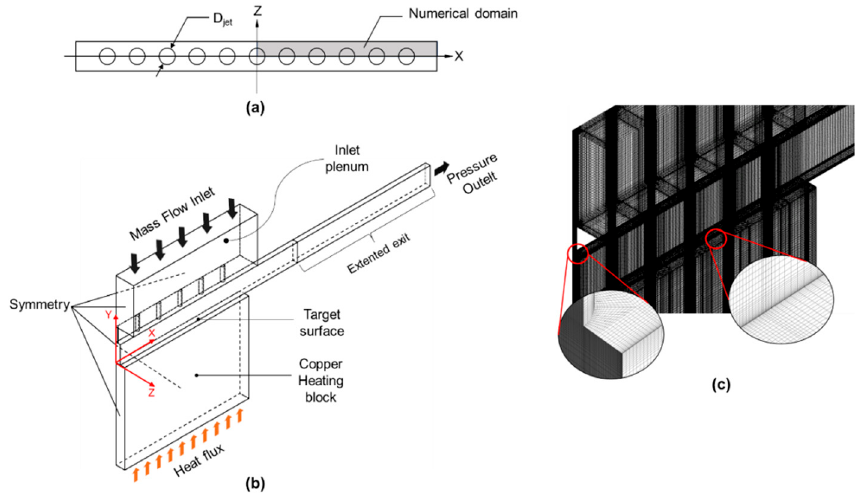
Figure 4. Numerical domain: ( a ) symmetry configuration; ( b ) boundary conditions; ( c ) grid system.